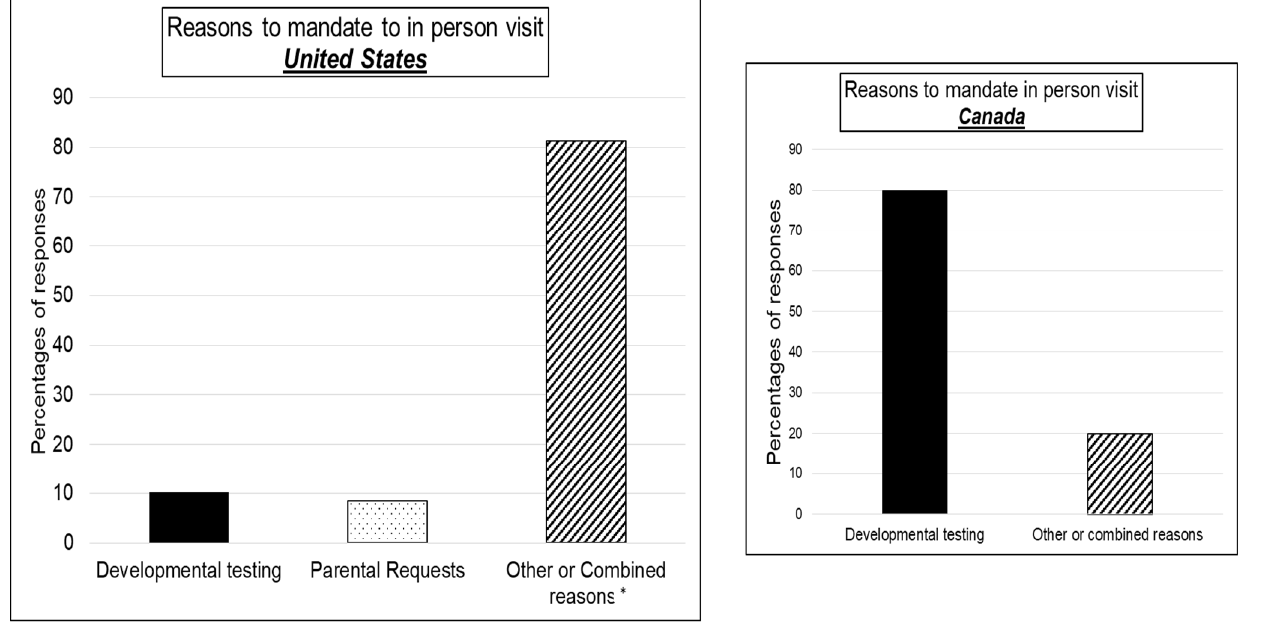
Figure 2. Approach to vitals measurements in HRIF clinic at the time of filling in the survey.